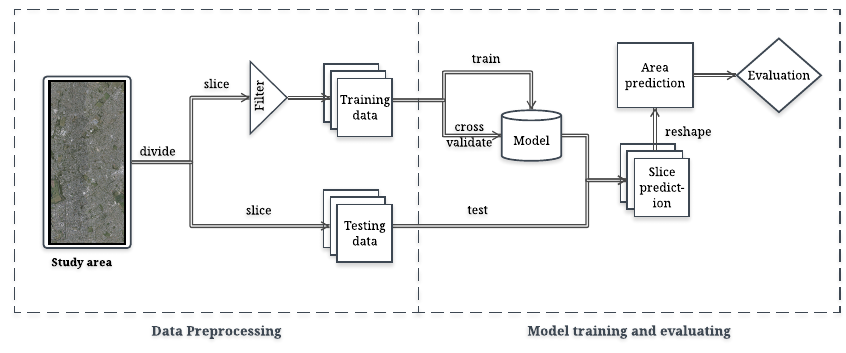
Figure 2. Workflow for our study. The proposed BR-Net method is trained and cross validated utilizing the training data. Later, evaluation of model performance is conducted by utilizing the testing